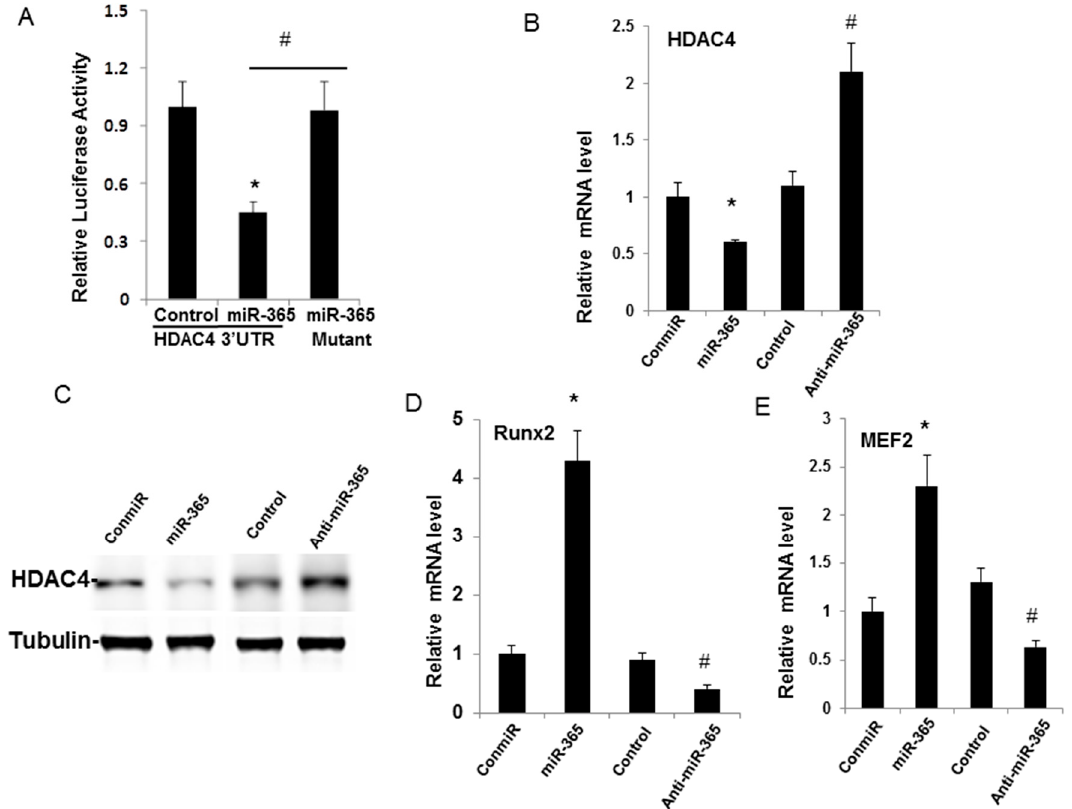
Figure 5. miR-365 directly targets histone deacetylase 4 (HDAC4). ( A ) Overexpression of miR-365 down-regulated luciferase activity of WT HDAC4 3 ′ -UTR, Human articular chondrocytes were co-transfected with a reporter carrying a WT or mutant of HDAC4 3 ′ -UTR along with miR-365 or its control mimics and were analyzed by dual luciferase assay. * p < 0.05, compared with the control; # p < 0.05, compared with the chondrocytes overexpressed with HDAC4 3 ′ -UTR and miR-365; ( B , D , E ) Human articular chondrocytes were transfected with miR-365 mimic or miR-365 inhibitor and their control. RNA was collected 48 h post-transfection. mRNA levels of HDAC4, Runx2 or MEF2C were detected with real-time PCR. * p < 0.05, compared with control miRNA mimic (ConmiR.); # p < 0.05, compared with control miRNA inhibitor (Control); ( C ) Western blot analysis of HDAC4 expression in human articular chondrocytes transfected with miR-365 mimic or miR-365 inhibitor and their control. Tubulin was used as the control.